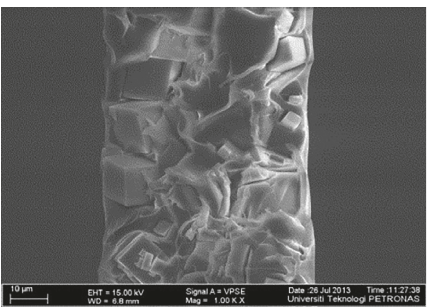
Figure 1: Sample of PES-SAPO-34 mixed matrix membranes with 10wt.% ionic